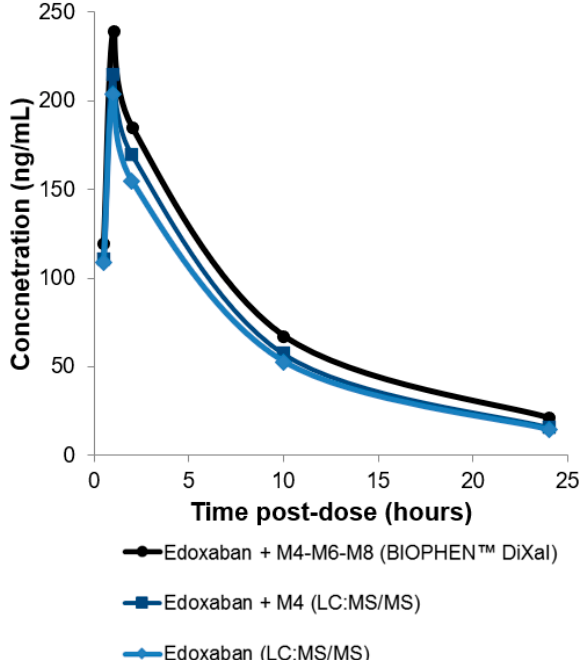
Figure 1. Measurement of edoxaban and active metabolites with a bioassay (BIOPHEN™ DiXaI) and edoxaban or edoxaban + metabolite M4 measurement with liquid chromatography–mass spectrometry (LC-MS/MS) in plasma samples from healthy volunteers (collected at different times after intake). Following edoxaban administration, rapid absorption occurred, resulting in peak plasma concentrations at 1 to 2 h, followed by a decline phase (data not published).